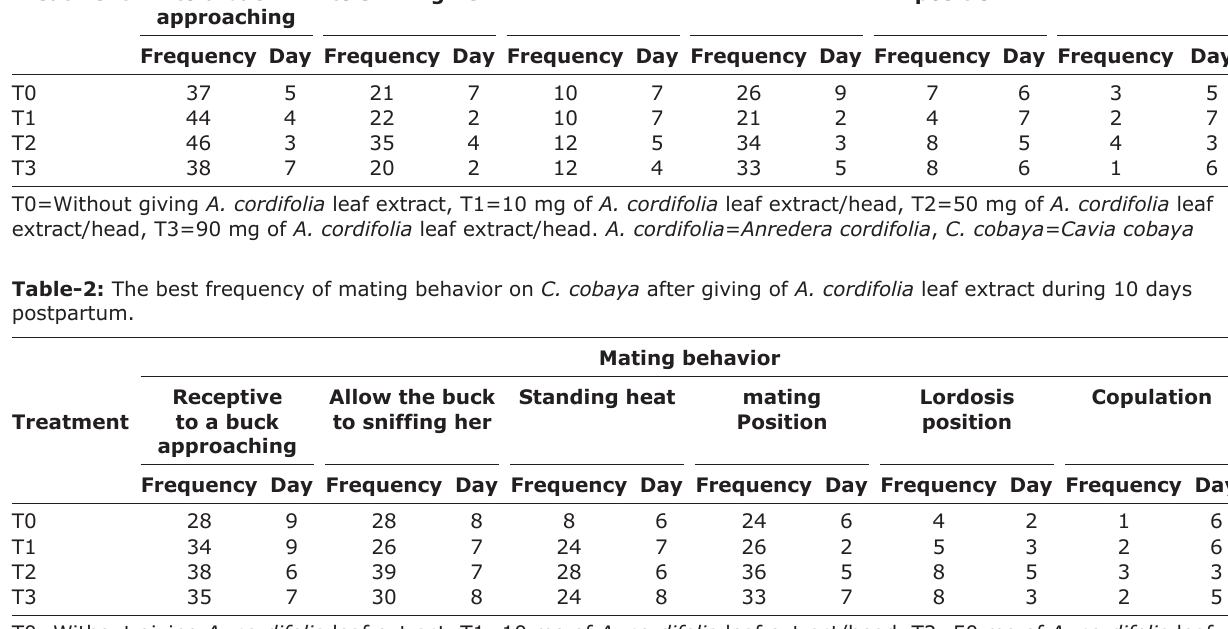
Table-1: The best frequency of mating behavior on C. cobaya after giving of A. cordifolia leaf extract during 10 days prepartum. Receptive Treatment to a buck approaching